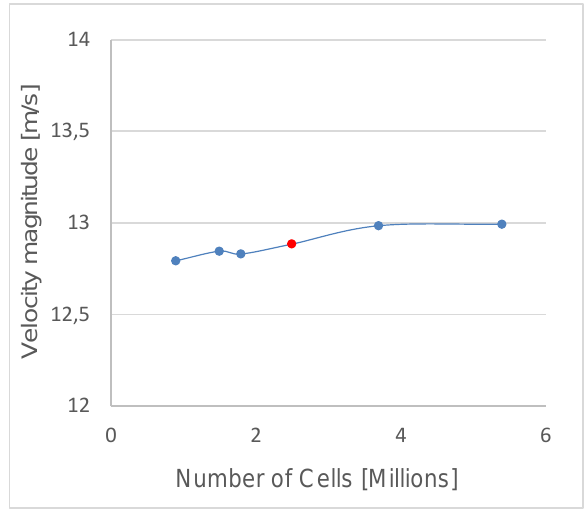
For the LES approach, a mesh consisting of 16.8 million of cells with elements size that passes the Taylor microscale [14] condition was generated. The boundary area of the LES approach-based mesh was treated with a prismatic layer that consist ten rows of hexahedral layers with near wall cell size that passes low wall-y + condition. This allowed the full simulation of the boundary layer.